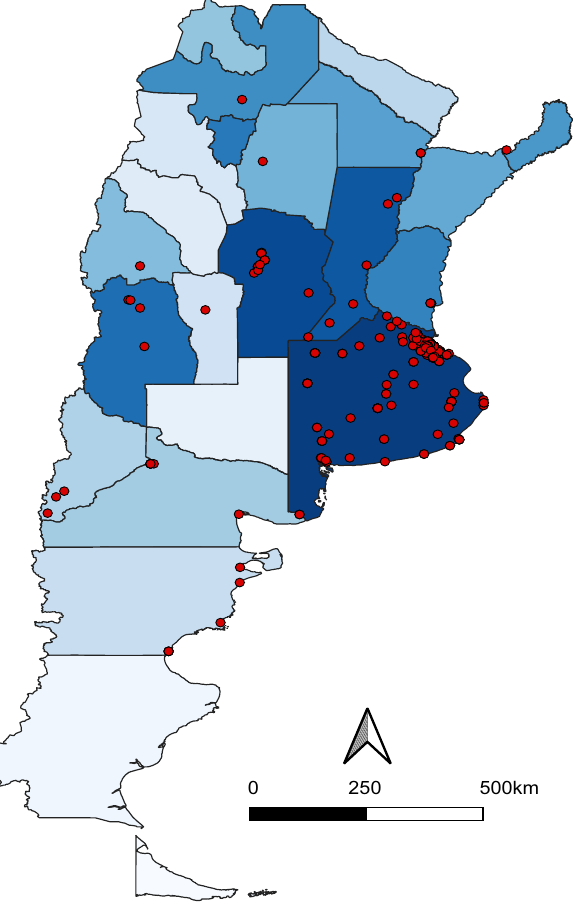
Figure 1. Geographic distribution of the questionnaire respondents (red dots). Blue gradient represents the number of inhabitants per province (state). Dark blue represents a higher number meanwhile light blue represents a lower number of inhabitants. Map was created in QGIS version 3.16 https:// www. qgis. org/ es/